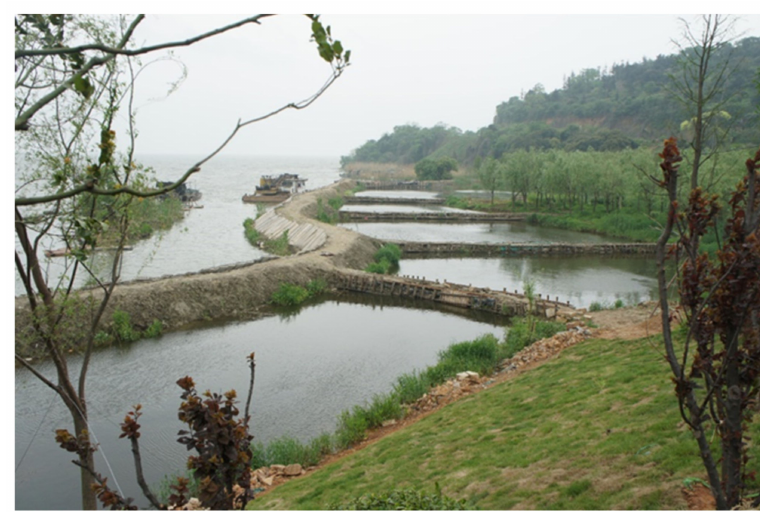
Figure 2. Experimental site in Tanxi bay of Lake Tai.